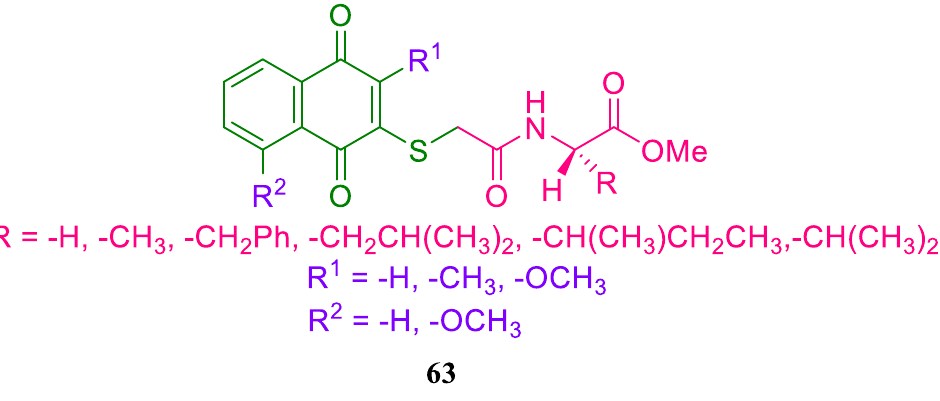
Figure 54. Naphthoquinone amide derivatives. Tahoori F et al. synthesised a series of cycloheptapeptides ( 64 – 67 ) incorporating